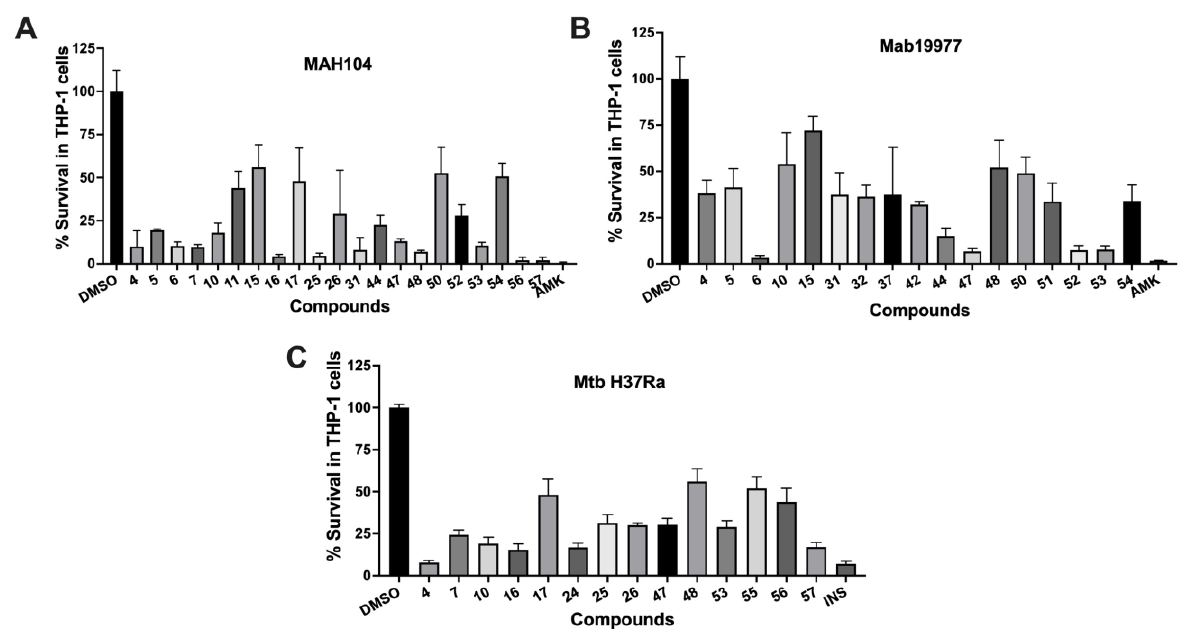
Figure 2. Quantification of bacterial CFUs for assessing intracellular potency of hit compounds against mycobacteria within infected THP-1 macrophages. Compounds at the highest nontoxic concentrations (listed in Table 2) were added to ( A ) MAH, ( B ) Mab, or ( C ) Mtb infected THP-1 cell monolayers at 2 h post-infection. Bacterial CFUs were analyzed by lysing cells with 0.1% Triton X-100 on day 6 for MAH, day 3 for Mab, and day 6 for Mtb and plating seral dilutions on 7H10 agar plates. The percentage of surviving bacteria was calculated by dividing CFU/well for each compound by DMSO growth control which is considered as 100% of bacterial survival. AMK treatment served as a negative control for MAH and Mab growth within macrophages and INH for Mtb. All compounds shown in this figure demonstrated a statistically significant reduction of intracellular bacteria (in p -value range of 0.05 – 0.0001) analyzed with one-way ANOVA multiple comparisons between DMSO control and experimental compound treatment groups. Table 3. Effect of compounds against M. avium and M. abscessus clinical isolates in